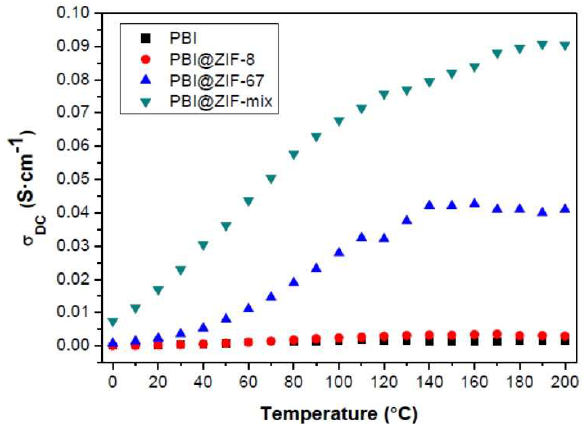
Figure 17. The temperature-dependent proton conductivity of H 3 PO 4 -doped PBI membrane and PBI composite membranes with 5 wt.% of ZIFs. Reprinted with permission from Ref. [57] under a Creative Commons Attribution (CC-BY) License. Copyright 2018 MDPI.